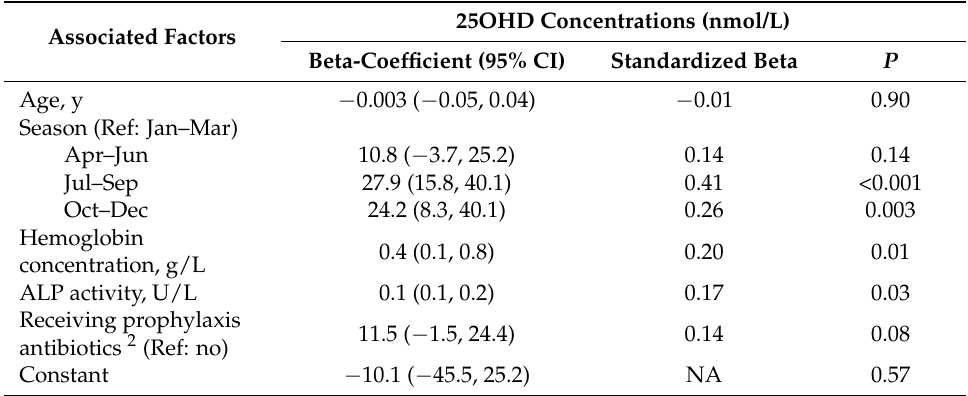
Table 3. Factors associated with serum 25OHD concentrations in Canadian children and adolescents (2–19 y) with sickle cell disease 1